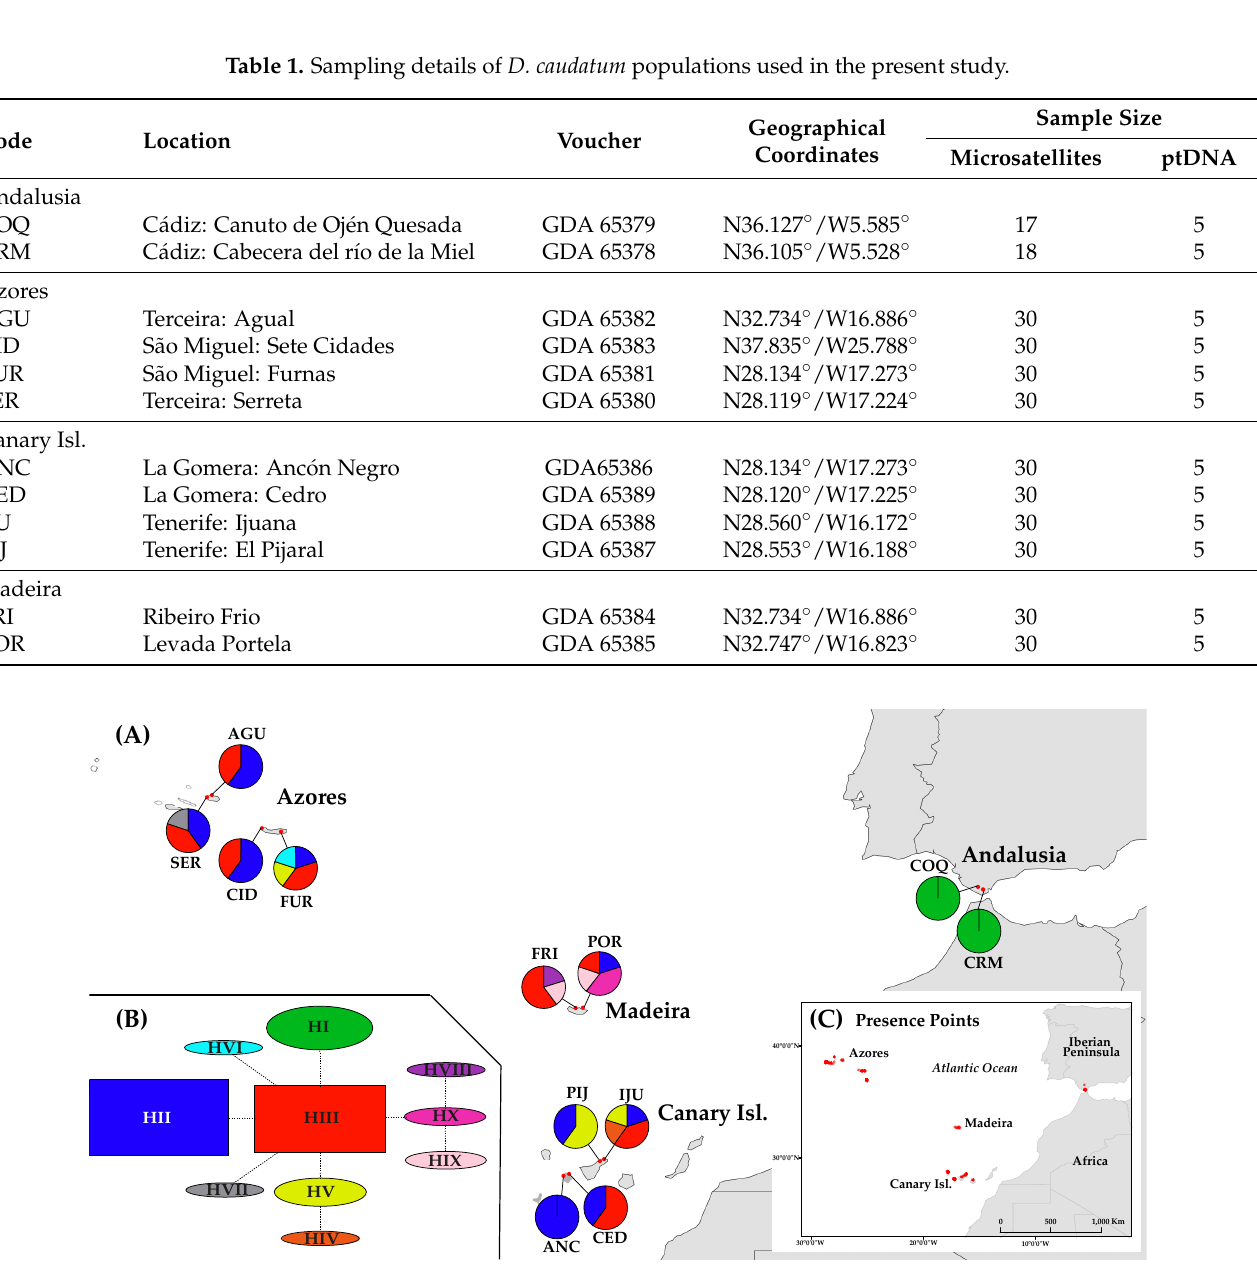
Figure 1. Distribution and haplotype composition of the population sampled of D. caudatum . ( A ) Geographical distribution of haplotypes (see Table 1 for population code); pie charts indicate haplotype frequency. ( B ) Network representing the relationships between haplotypes of the ptDNA; inferred following the statistical parsimony method, with TCS. ( C ) Location of presence records (black dots) used for species distribution modelling (SDM).